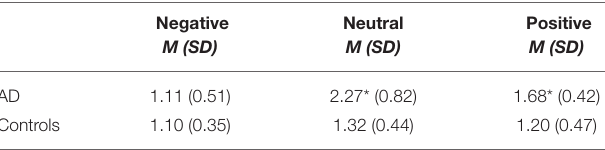
TABLE 4 | Means and SDs of change scores per stimulus category and group.